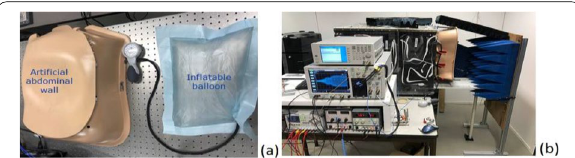
Fig. 1. The measurement set-up used in this investigation. (a) Using an inflatable balloon, IAP was elevated in the artificial abdominal model. (b) The TRM set-up used for IAP measurements At each pressure value, the 10-GHz-transient-radar signal was directed towards the AW and its time-dependent reflection was recorded 3 times at each IAP value and further processed by applying advanced signal processing techniques [6].